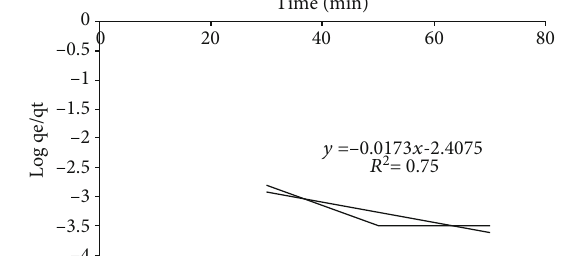
y = – 0.0173 x -2.4075 R 2 = 0.75